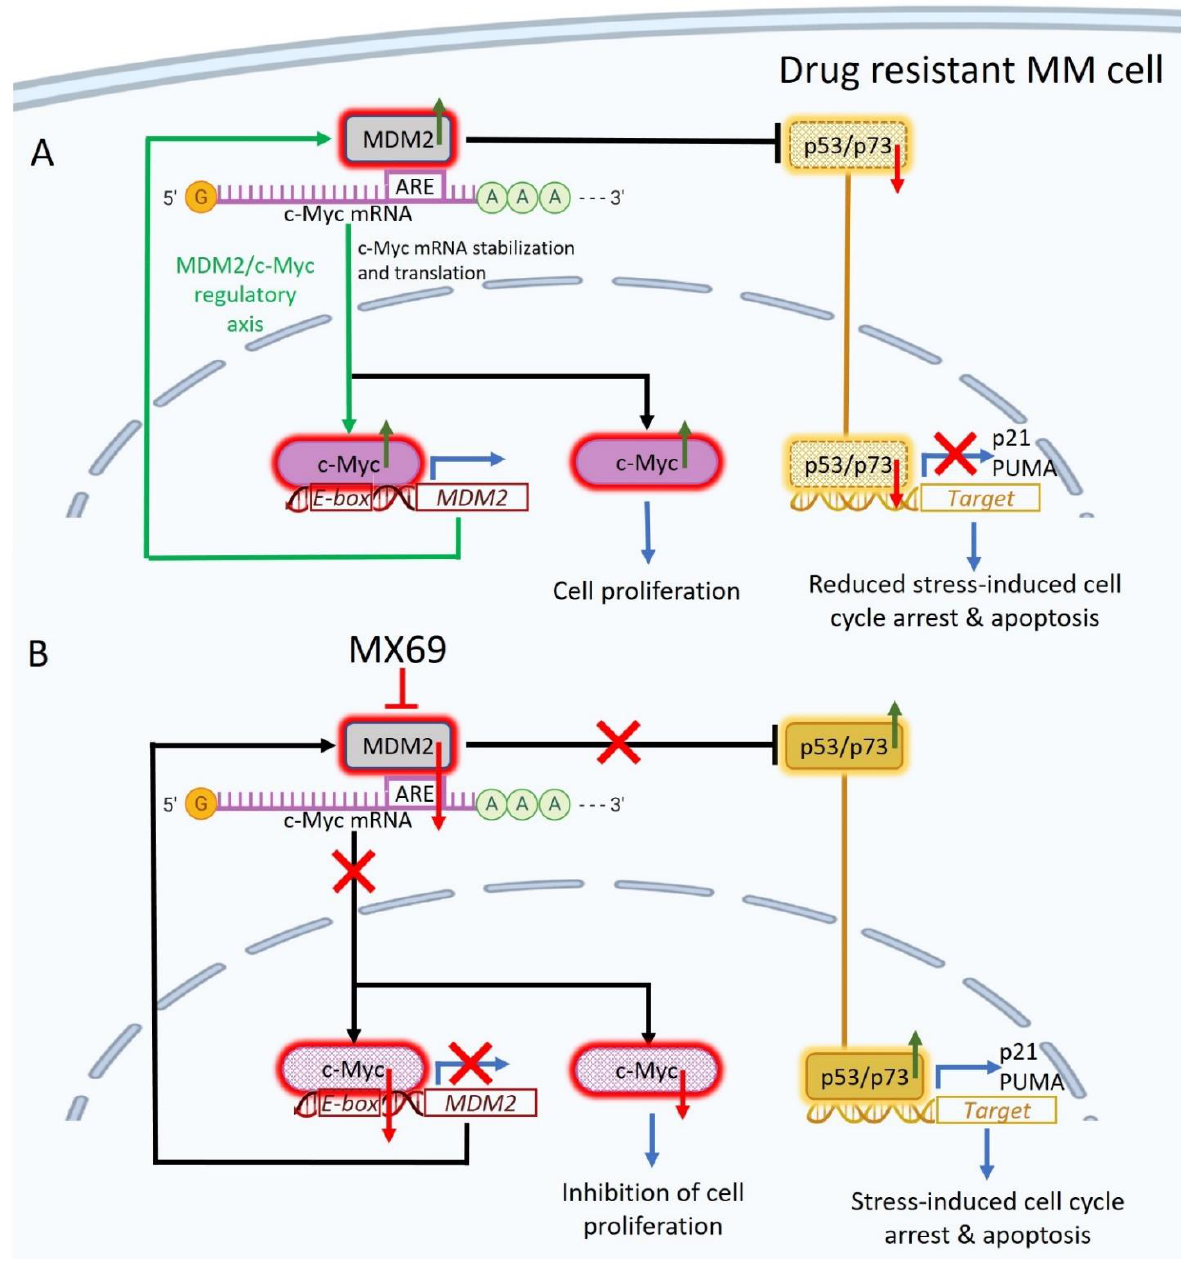
Figure 8. Targeting the MDM2/c-Myc regulatory axis in MM. ( A ) Proposed model of